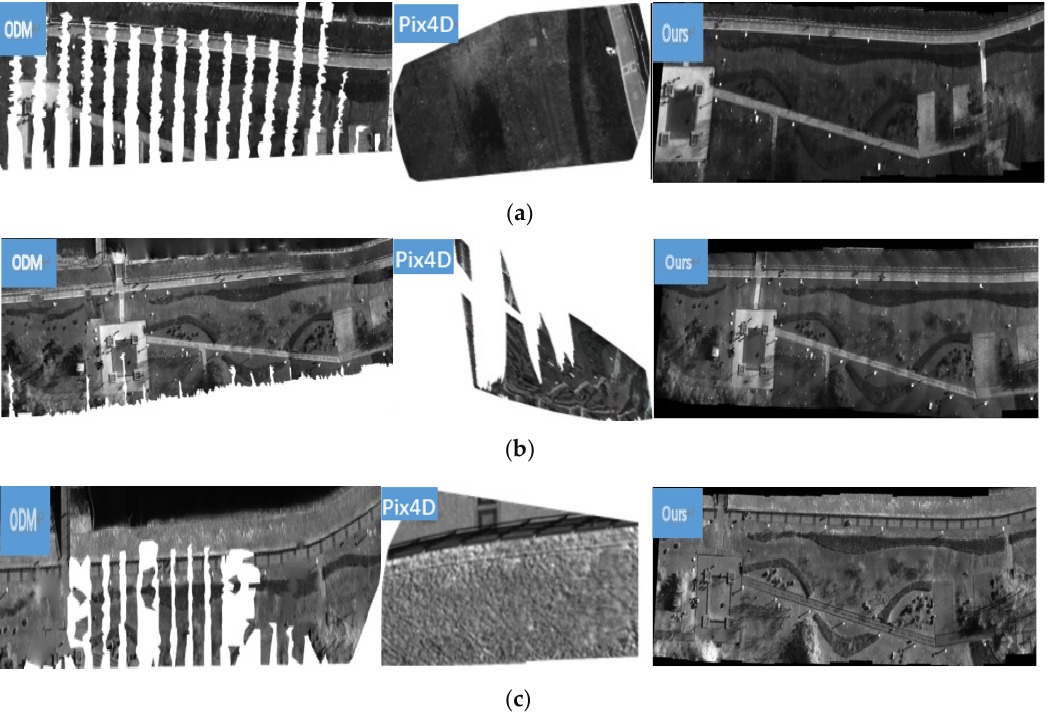
Table 4. RMSE values of two methods on color aerial image mosaic. Methods